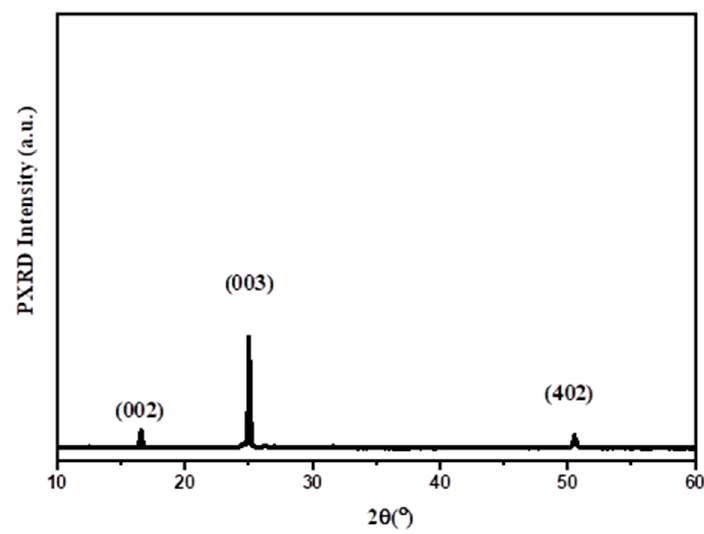
Figure 4. XRD pattern of the prepared MA 3 Sb 2 I 9 film on the FTO substrate.